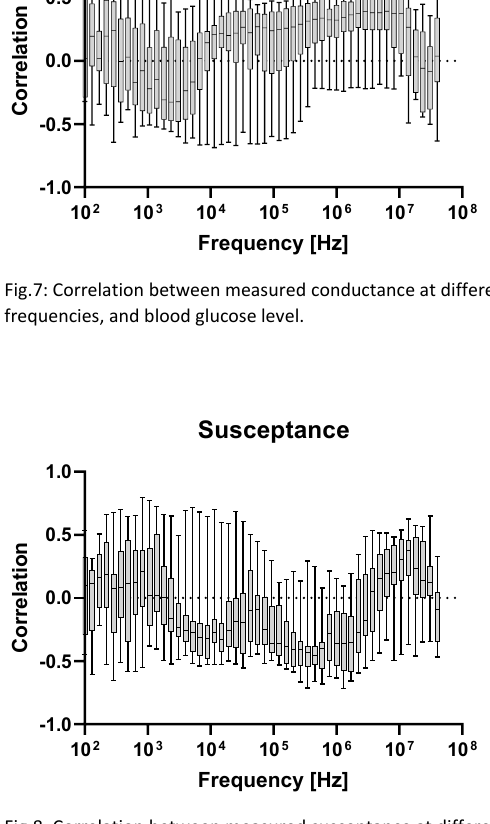
Fig.8: Correlation between measured susceptance at different frequencies, and blood glucose